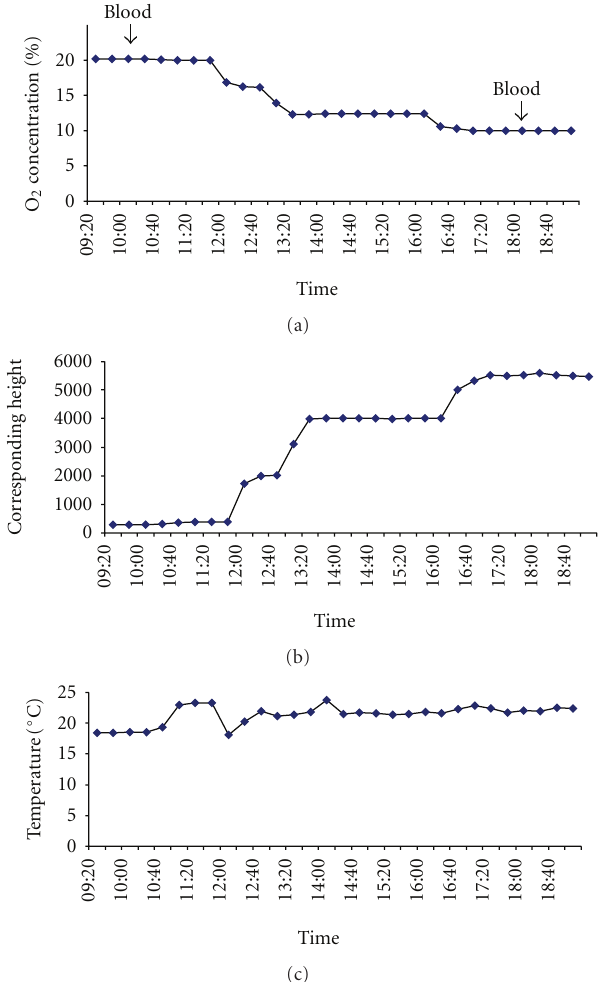
Figure 1: Time course of oxygen concentration and corresponding height and temperature in the hypoxia chamber during the experi- mental period. Times of blood collections are indicated by arrows.